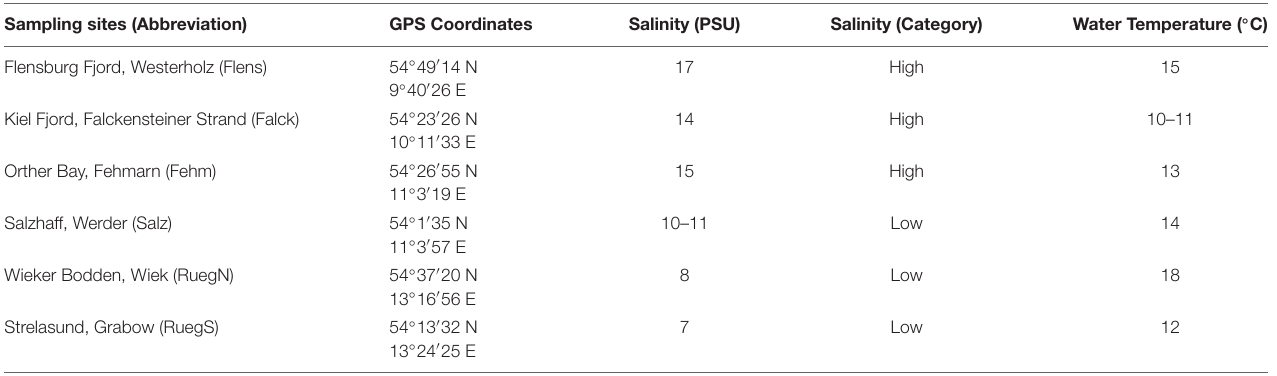
TABLE 1 | Pipefish sampling sites with coordinates, sampling date and ambient salinity and water temperature. Sampling sites (Abbreviation) GPS